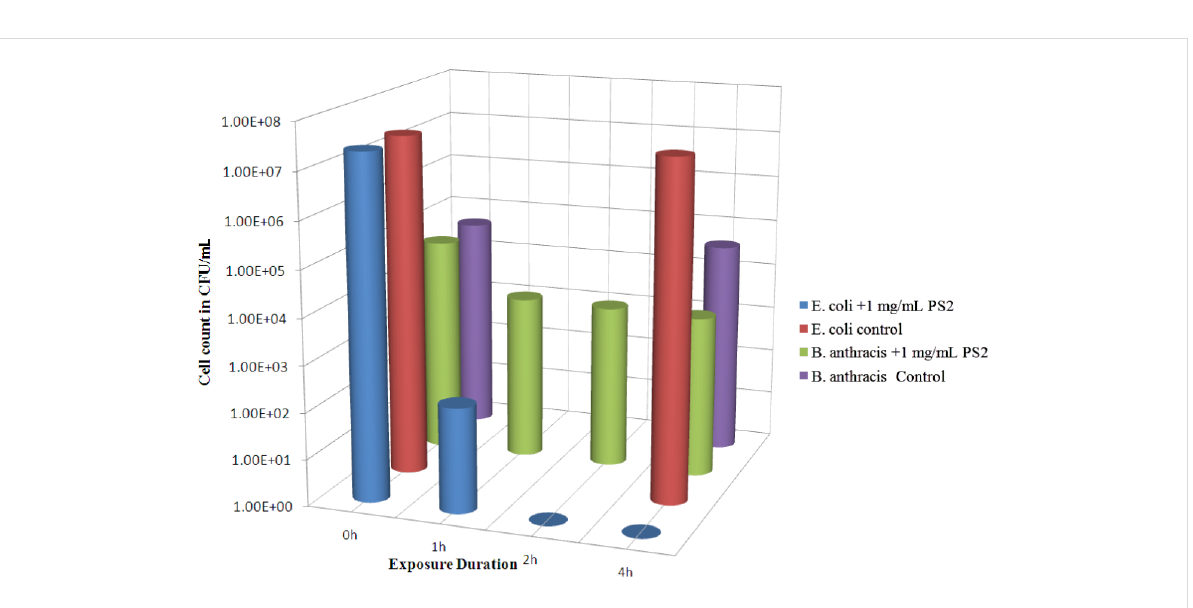
Figure 1: SEM micrograph of CuO nanorods (PS2) at a) 5000× and b) 40000×. c) EDX spectrum of the as-synthesized precursor of PS2. d) EDX spectrum of PS2.